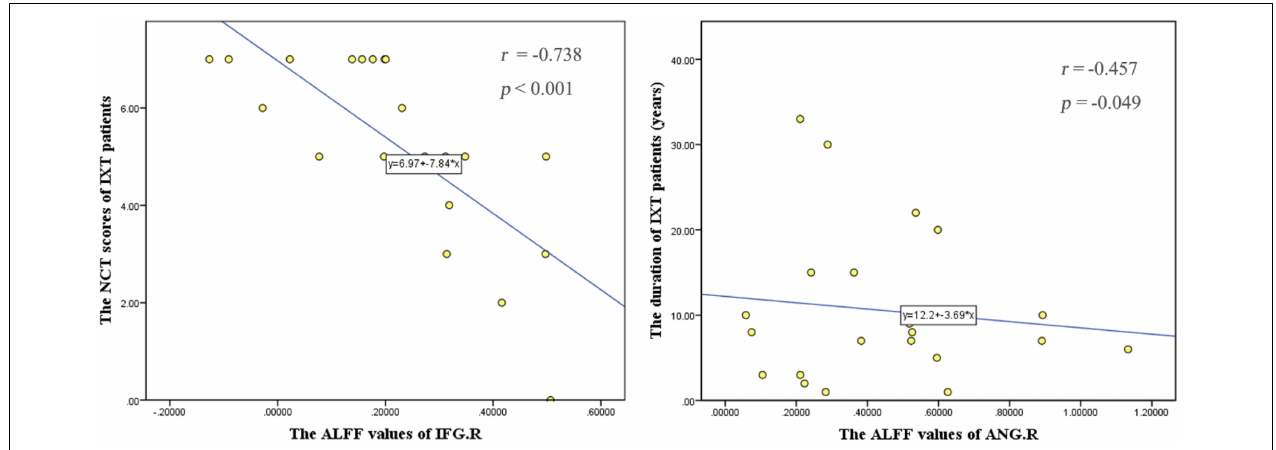
FIGURE 5 | Correlations between the ALFF values and behavioral performance in IXT patients. The NCT scores were negatively correlated with ALFF values in the right IFG ( r = –0.738, p < 0.001). The duration of IXT was negatively correlated with ALFF values of the right ANG ( r = –0.457, p = 0.049). IFG: inferior frontal gyrus; ANG: angular